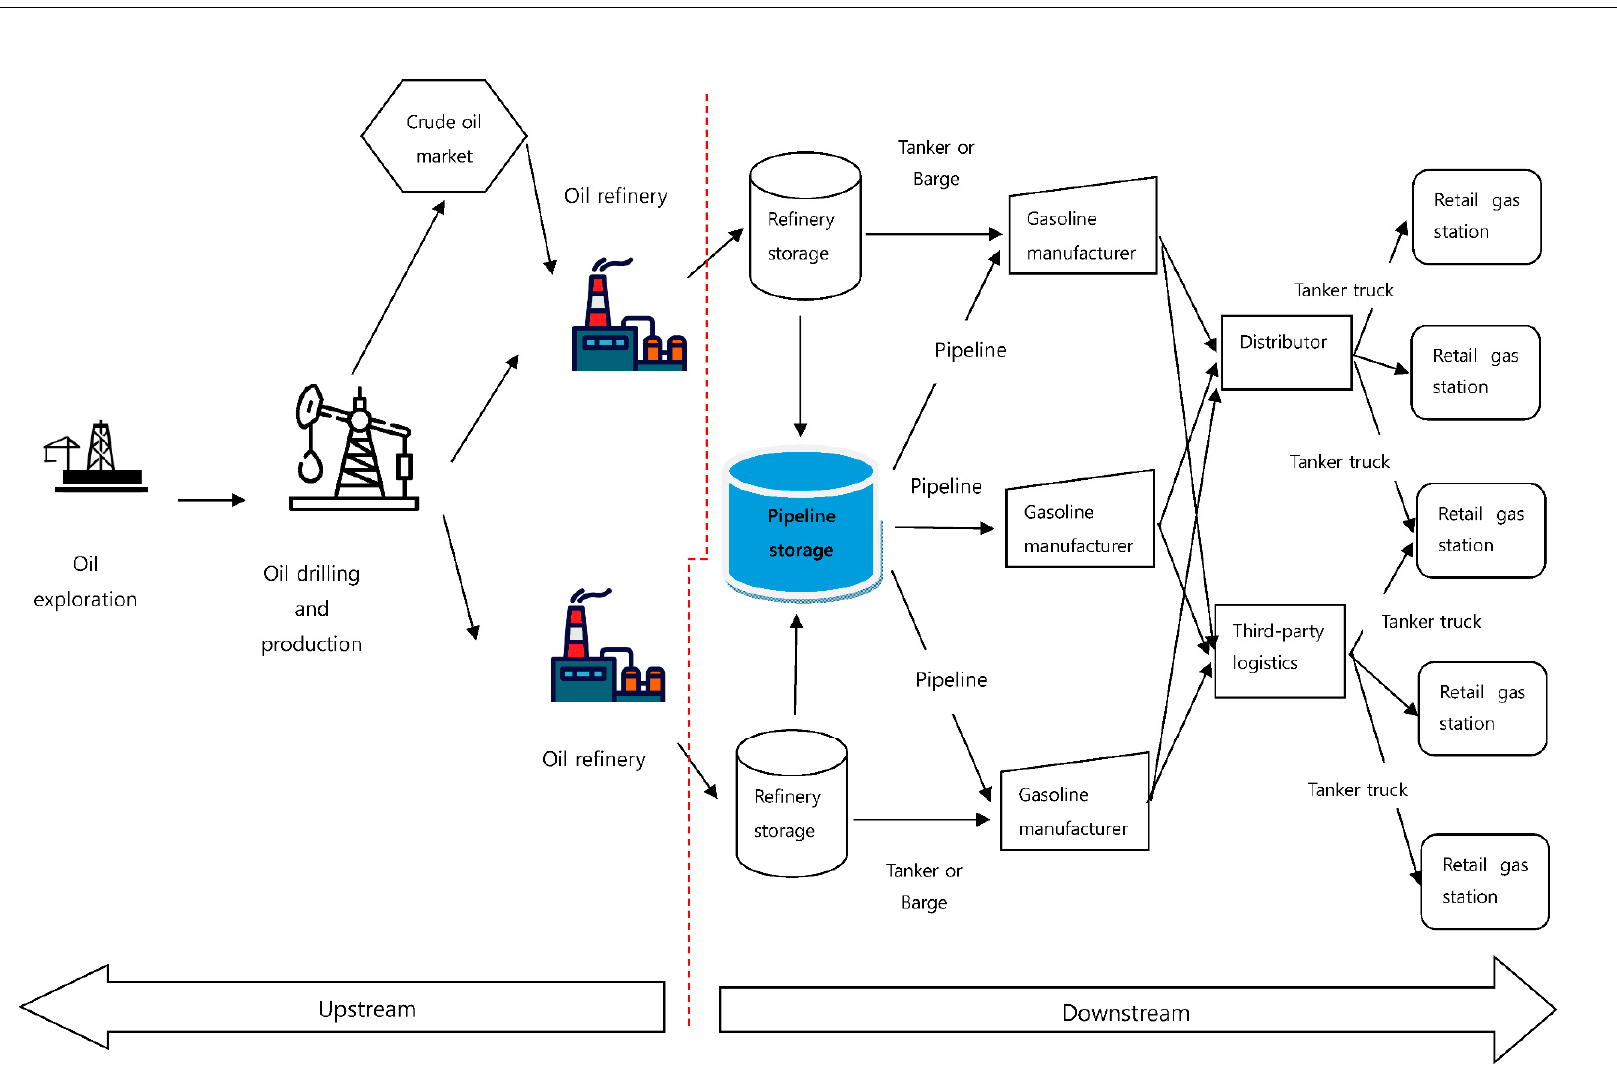
Figure 9. Oil/Gasoline Supply Chain.